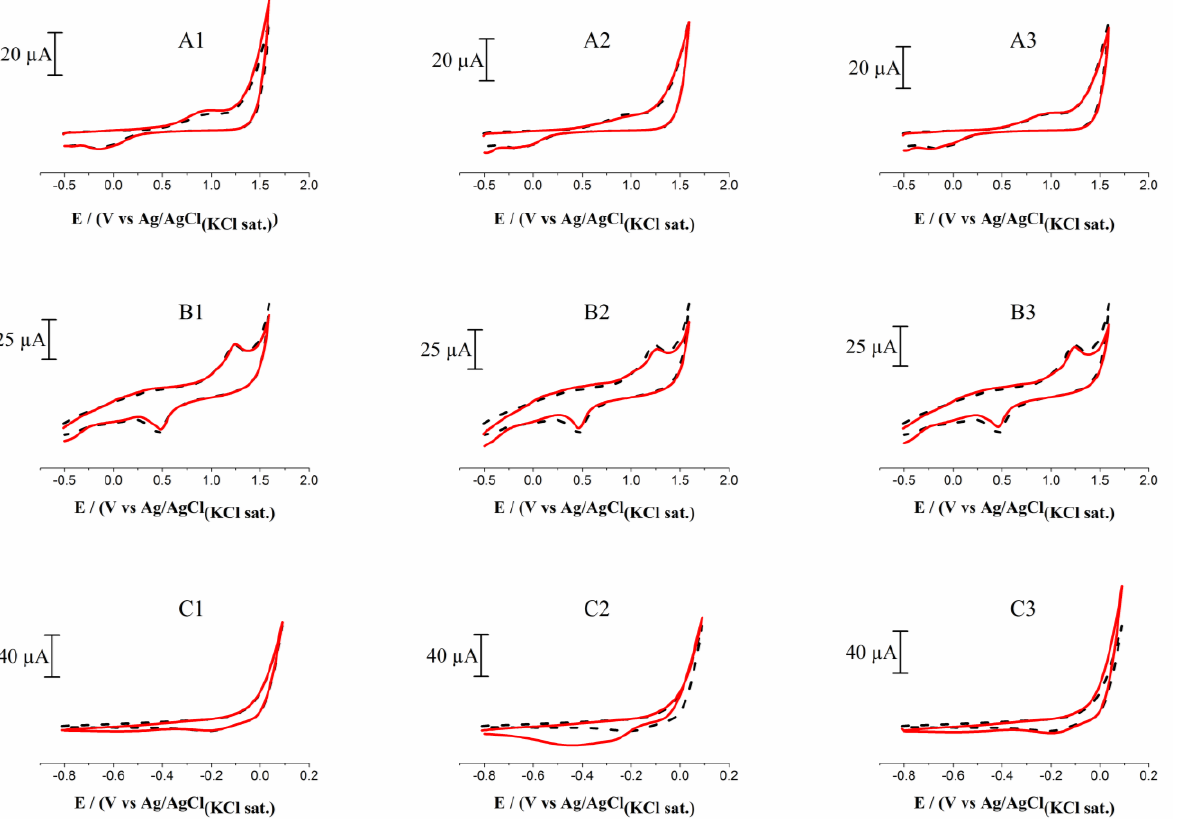
Figure 1. ( A ) Cyclic voltammograms recorded directly on commercial (Elegê ® ) whole milk sample using platinum; ( B ) gold; and ( C ) copper working electrodes, in the absence (dashed lines) and presence (full lines) of 10.0 mmol·L −1 of formaldehyde (1), 0.95 mmol·L −1 of melamine (2), and 4.16 mmol·L −1 of urea (3). Scan rate = 100 mV·s −1